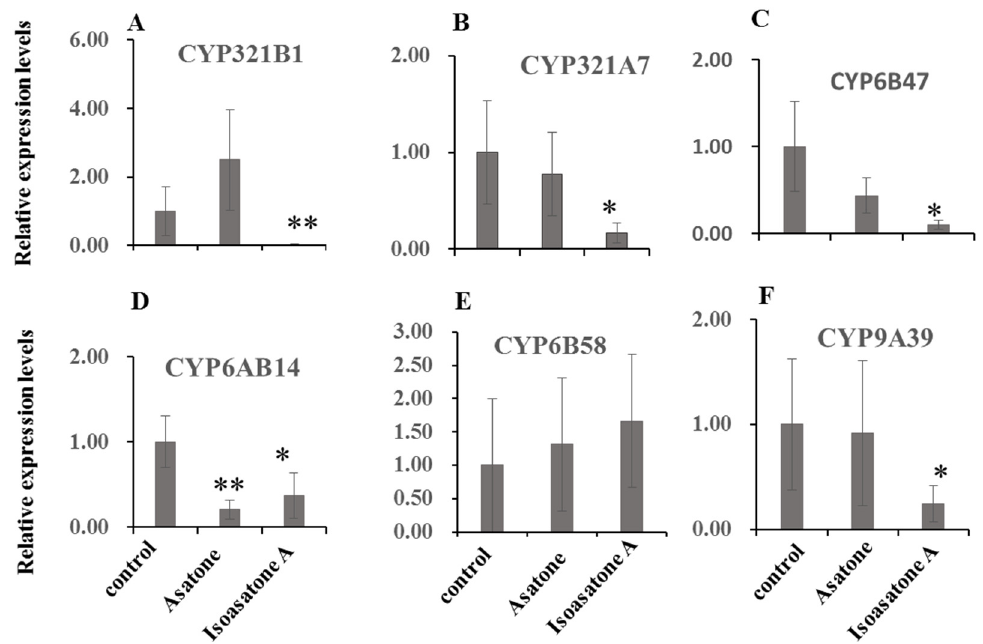
Figure 4. Expression levels of selected genes. ( A – F ) P450s, β -actin gene served as an internal reference to determine relative expression levels. Data shown are mean +/ − s.e.; n = 3–5. Asterisks indicate significant differences relative to control (* p < 0.05, ** p < 0.01) in a t -test.